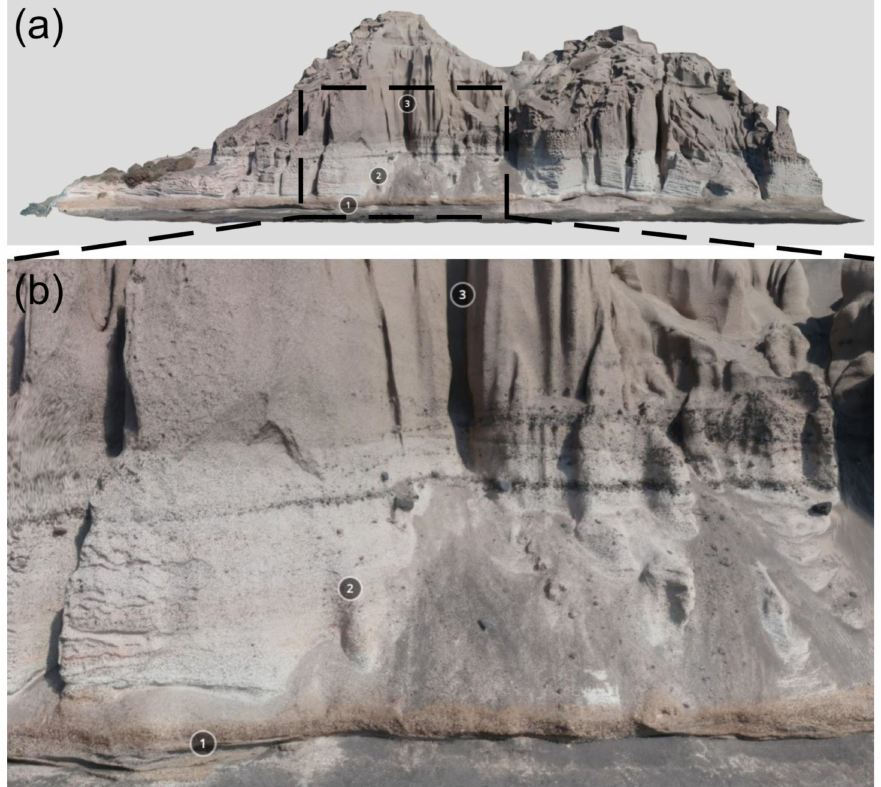
Figure 9. ( a ) A 3D model panorama view along Vlychada beach (view towards the north) and ( b ) a closer look at the Minoan eruption phases and morphological features ( pinmarks 1–3